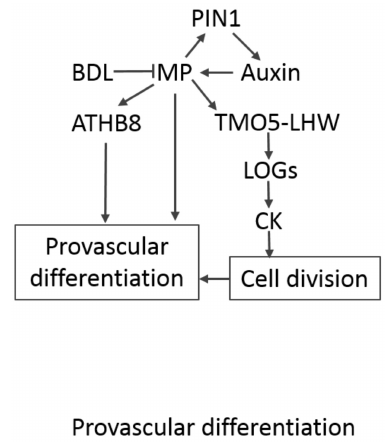
Figure 1. Arabidopsis provascular differentiation. MONOPTEROS (MP) is a central regulator in provascular development. It is induced by auxin and promotes auxin flow by induction of PIN-FORMED (PINs) . MP function is also modified by BODENLOS (BDL). MP enhances ATHB8 expression, which contributes to provascular differentiation. It also regulates the TAGRET OF MONOPTEROS 5 (TMO5)–LONESOME HIGHWAY (LHW) dimer, which activates CK (cytokinin) biosynthesis and promotes cell division. LOG—LONELY GUY.